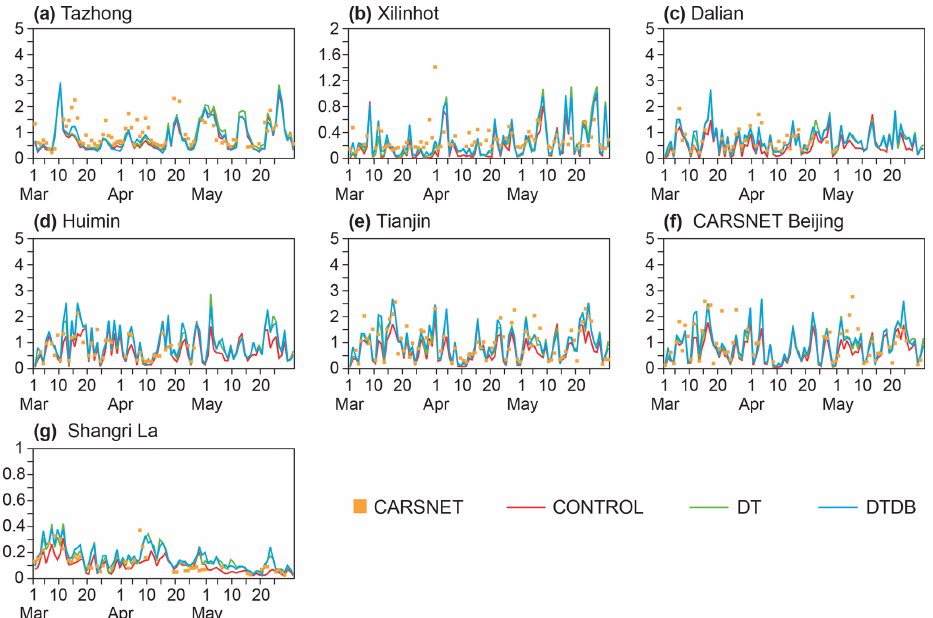
Figure 7. Comparison of CARSNET aerosol optical depth data (blue squares) with model aerosol optical depth at several CARSNET stations highlighted in Fig. 1 during the period March–May 2013. Red corresponds to experiment CONTROL, green to experiment DT and blue to experiment DTDB. From (a) to (g) : Tazhong (39.0 ◦ N–83.67 ◦ E), Xilinhot (43.95 ◦ N–83.67 ◦ E), Dalian (38.90 ◦ N–121.63 ◦ E),